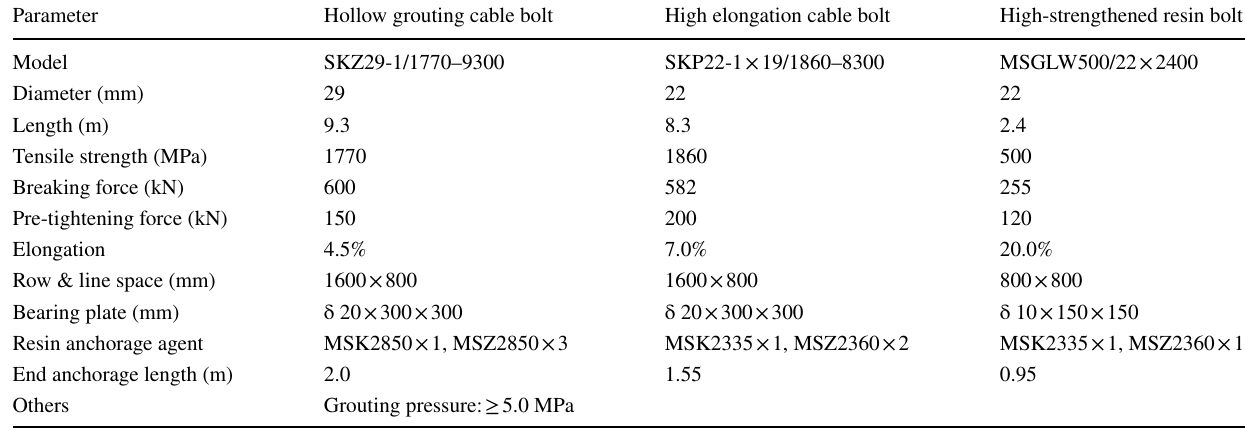
Table 5 Parameters of anchor bolt (cable) for strengthening support